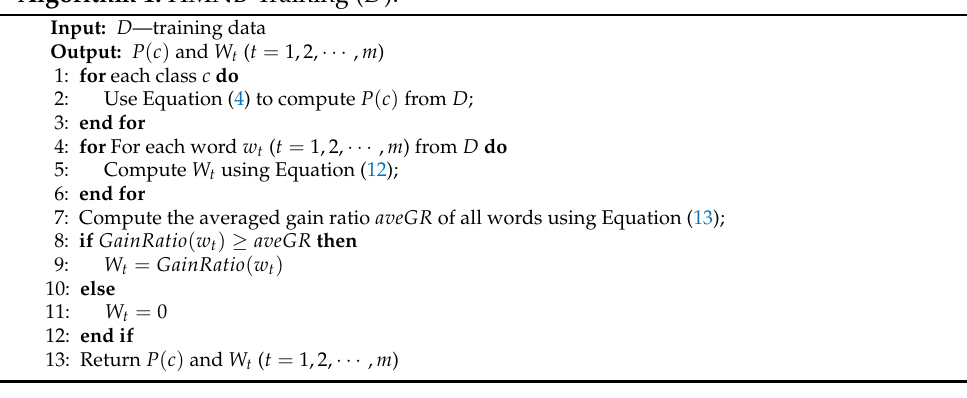
Algorithm 1: HMNB-Training ( D ).